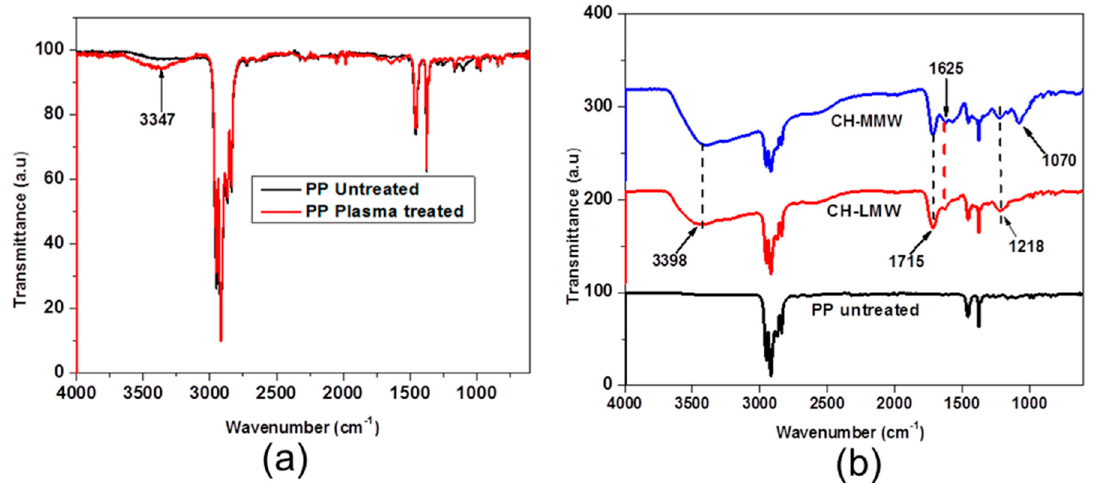
Figure 5. Fourier transform infrared (FTIR) spectra (attenuated total reflection (ATR)): ( a ) PP control and oxygen plasma-treated PP meshes; ( b ) PP control, CH-LMW, and CH-MMW and levofloxacin-coated PP meshes. PP